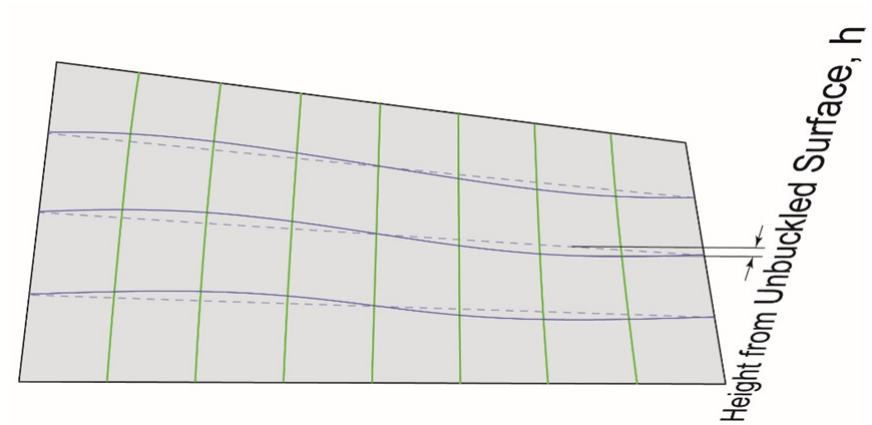
Fig. 4 Identification of Buckling by Deviation from Unbuckled